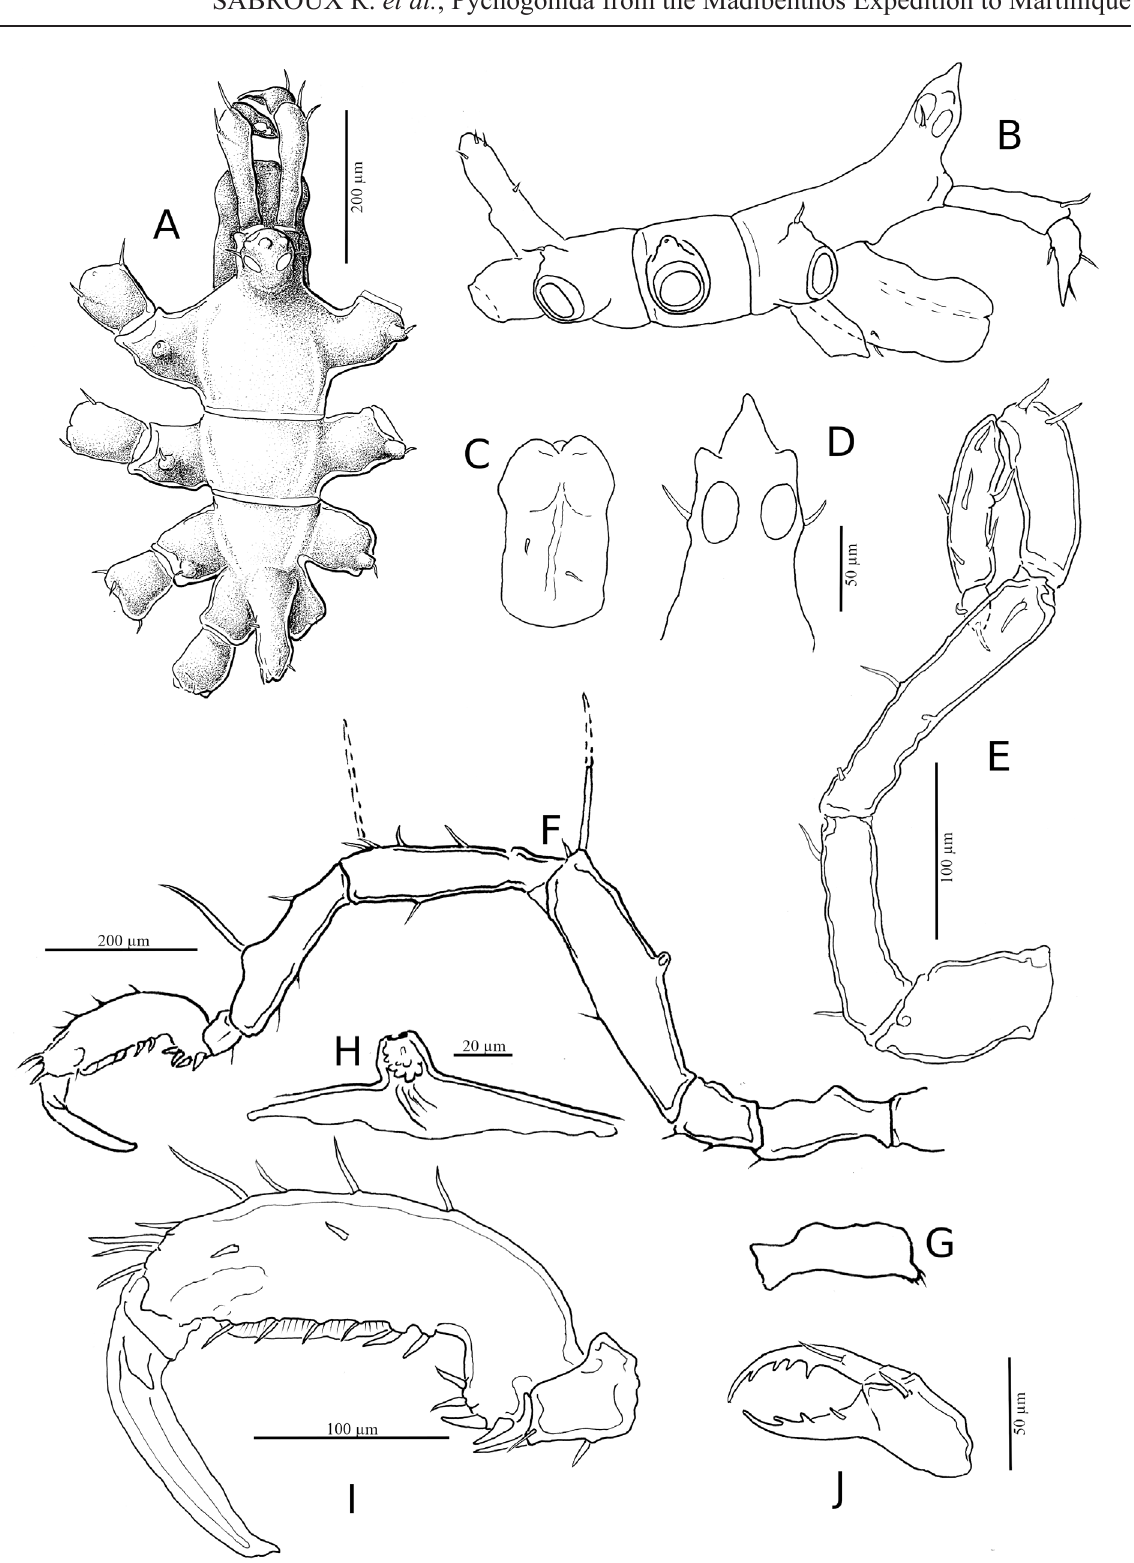
Fig. 24. Anoplodactylus micros Bourdillon, 1955, neotype, ♂, MNHN-IU-2016-1325. A . Body, dorsal view. B . Body, lateral view (same scale as A). C . Proboscis in ventral view (same scale as A). D . Ocular tubercle, frontal view. E . Oviger. F . Second leg. G . Cement gland opening of second leg. H . Coxa 2 of third leg. I . Tarsus and propodus of second leg. J .